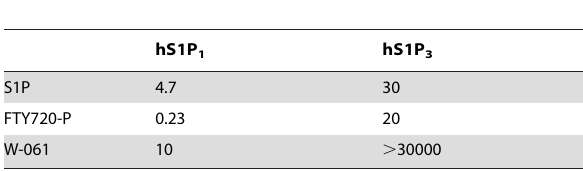
Table 2. Agonistic activity of W-061 on S1P 1 and S1P 3